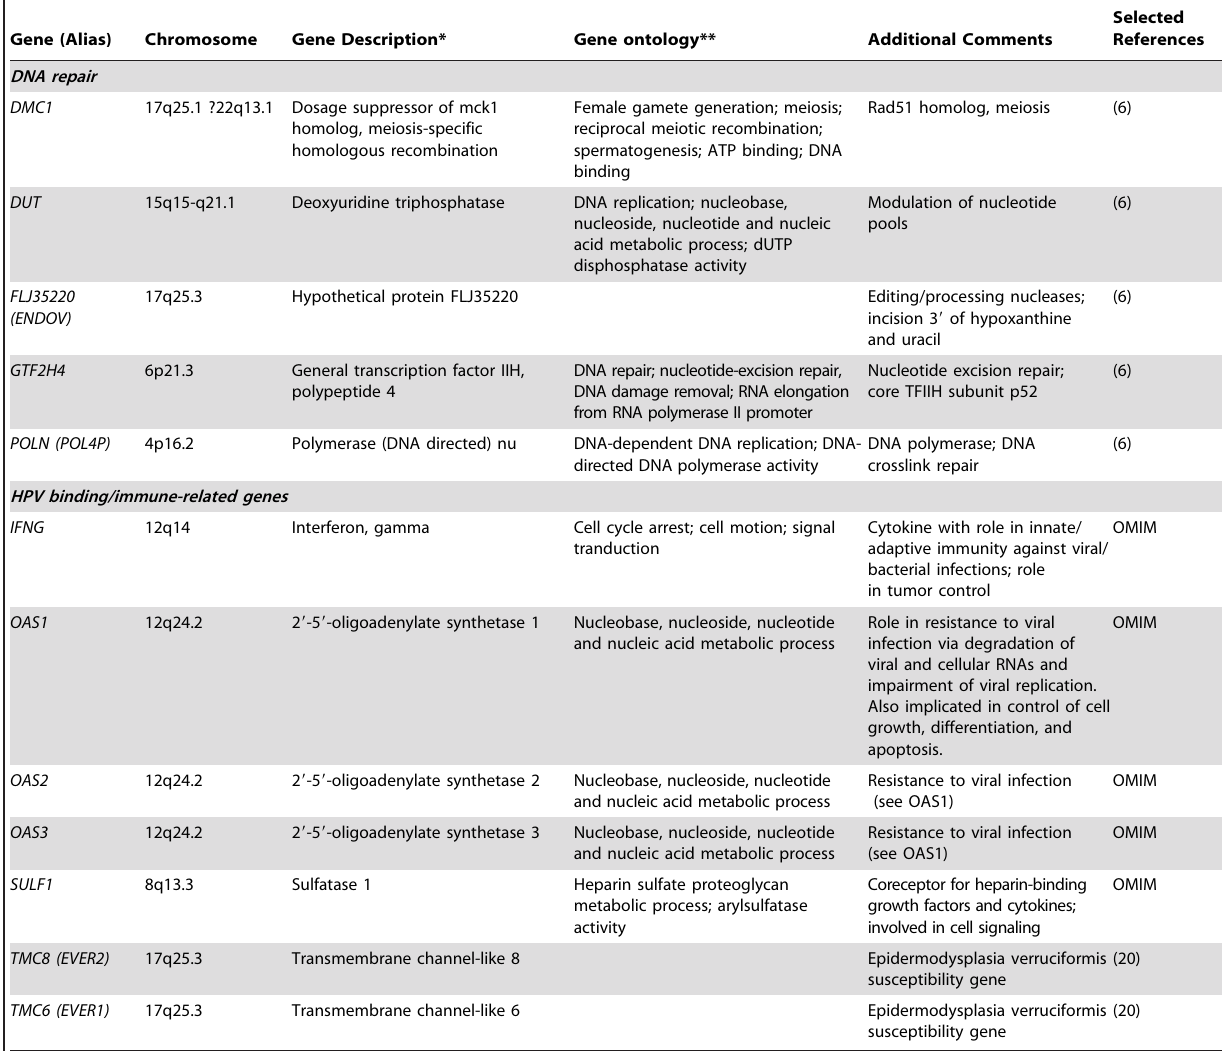
Table 4. Description of top-ranked